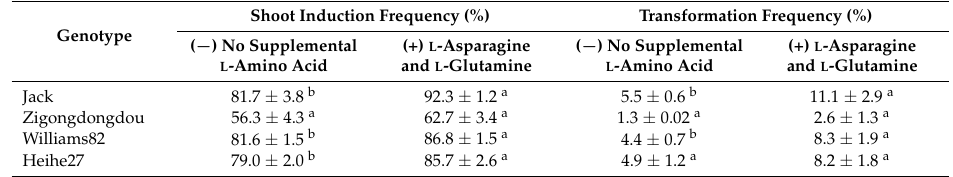
Table 5. Shoot induction frequency and transformation frequency in four soybean